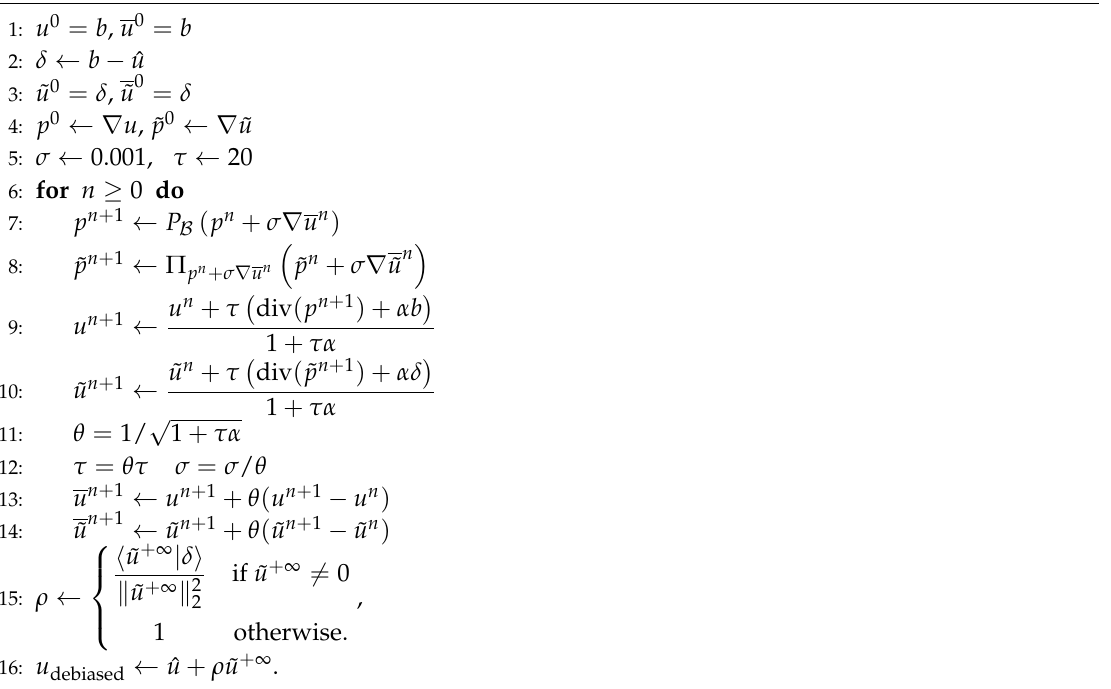
Algorithm 3 Debiasing of Algorithm